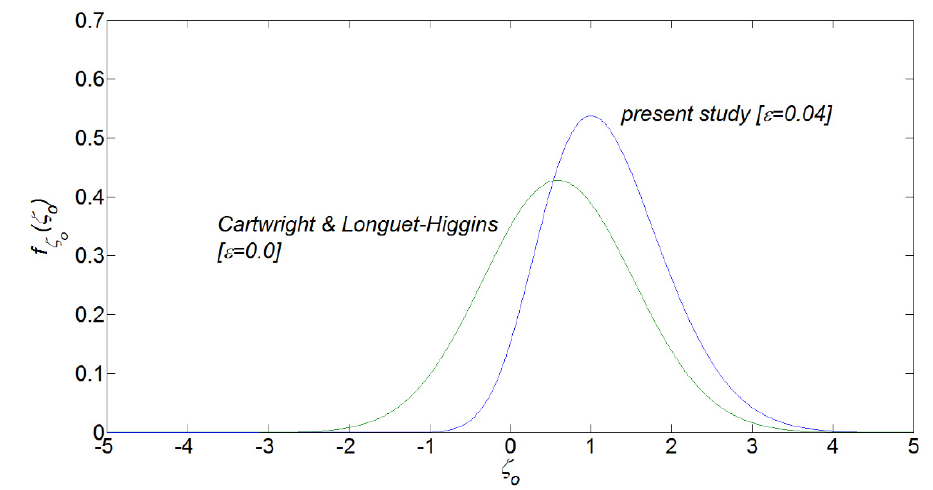
Figure 3. Comparison of wave crest distribution of nonlinear random waves of finite bandwidth with linear counterpart by Cartwright and Longuet-Higgins [33].